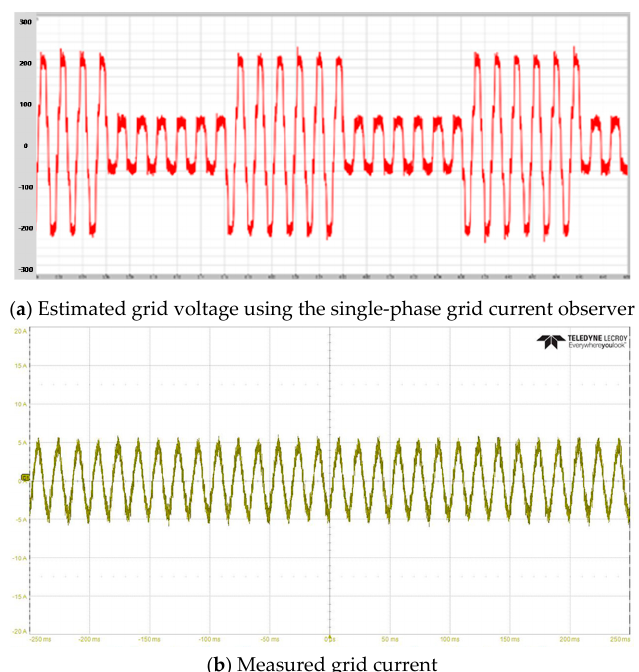
Figure 11. Experimental results when the proposed current control method is used under line-to-ground grid voltage fault condition.